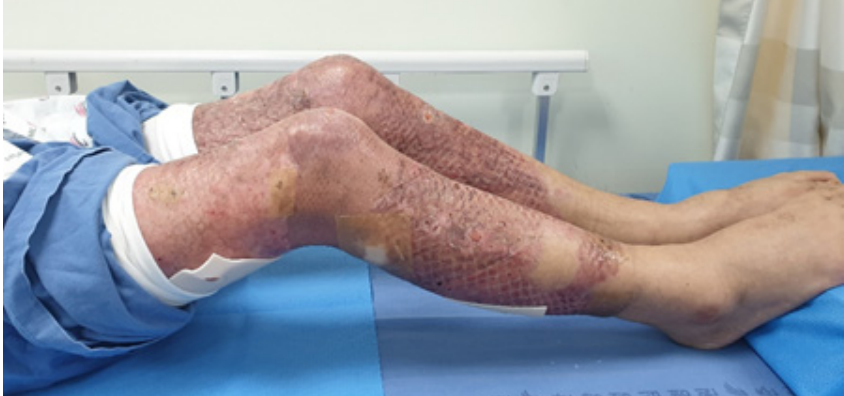
Figure 2. Eligible participant with a burn injury in lower extremity.